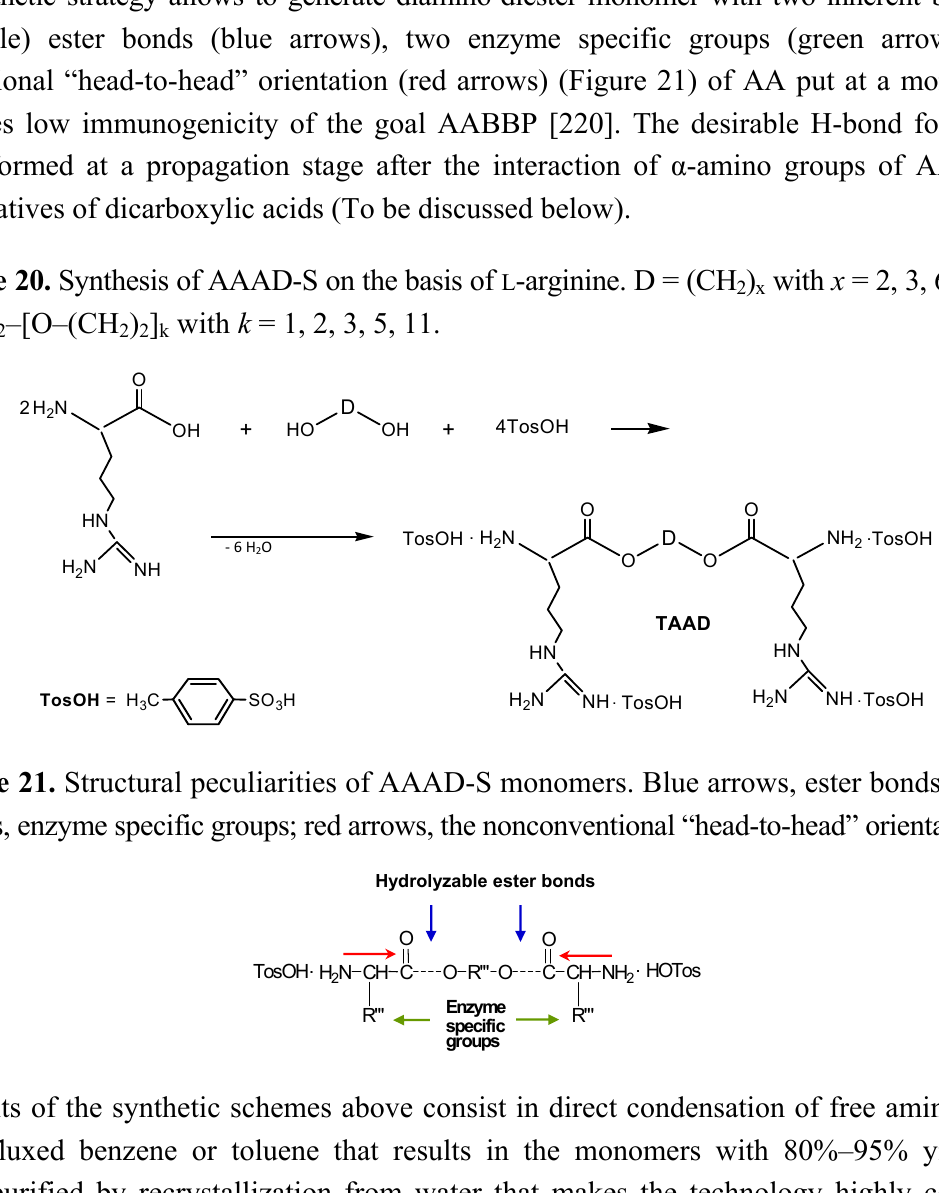
Figure 20. Synthesis of AAAD-S on the basis of L -arginine. D = (CH